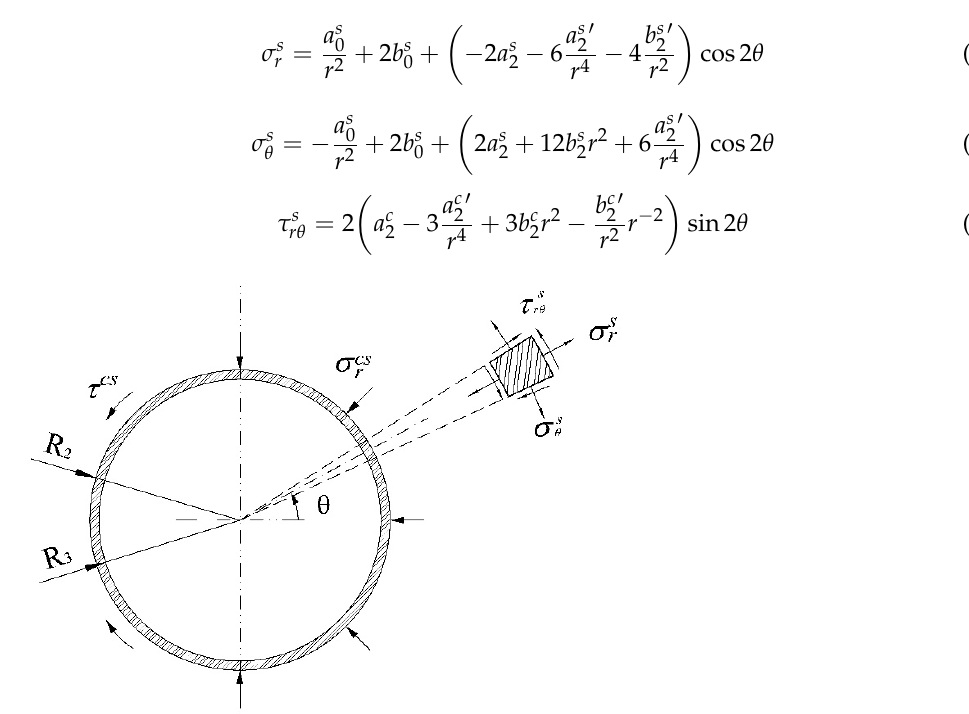
Figure 6. An illustration of stress condition in the steel plate.